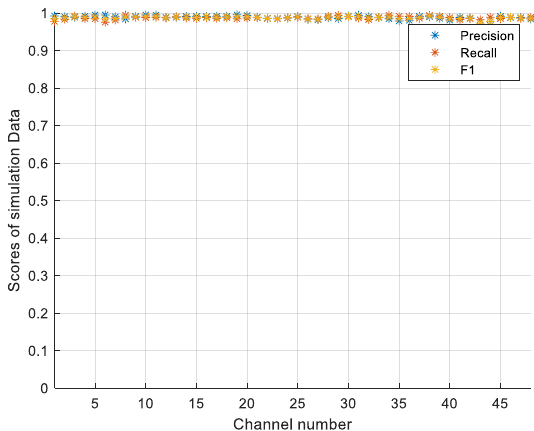
Figure 17. The random subspace kNN validation results (precision, recall and F1) of simulation data of all 48 hydrophones.